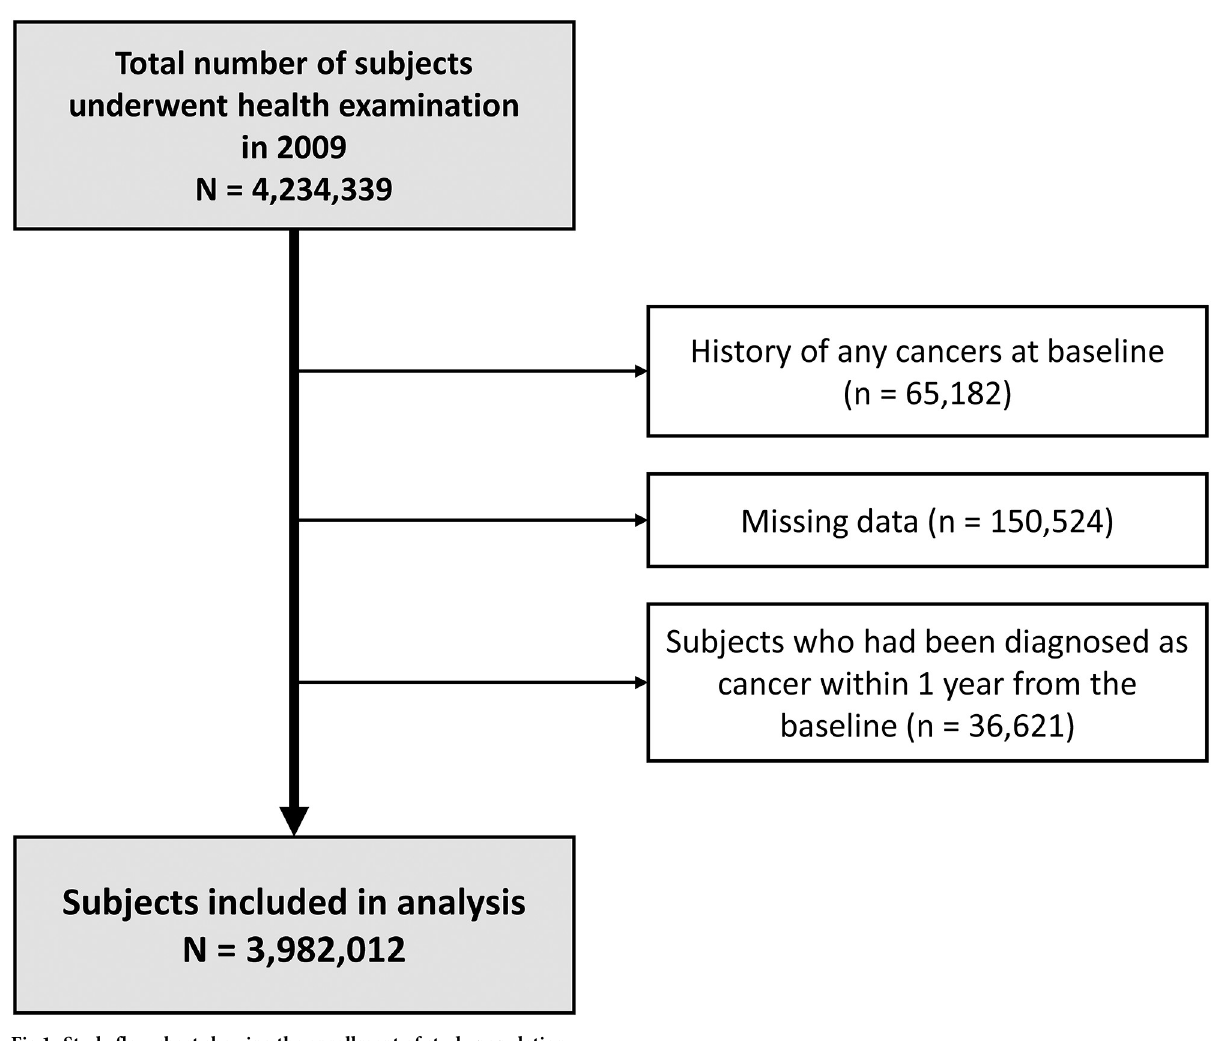
Fig 1. Study flow chart showing the enrollment of study